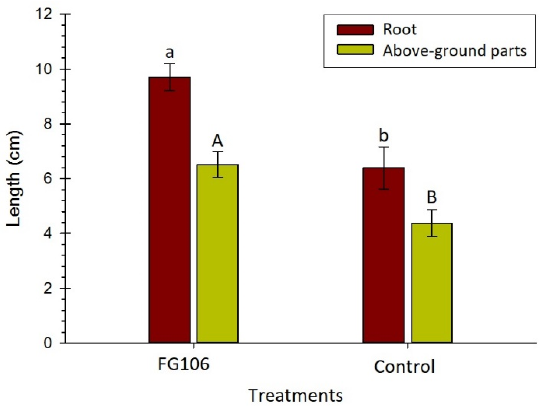
Figure 4. Longitudinal root growth ratios of tomato plants after bacterial inoculation with FG106 and under control conditions. Error bars represent the standard deviation (number of samples = 18); means labelled with different letters differ significantly according to Student’s t test at p < 0.01).